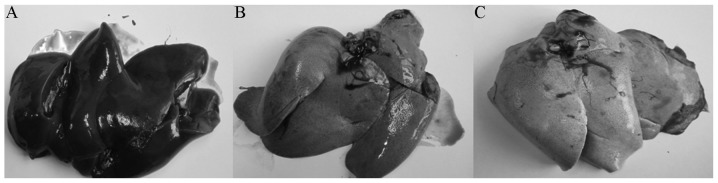
Gross samples of rabbit livers. (A) Normal liver. (B) Non-alcoholic fatty liver. (C) Alcoholic fatty liver.